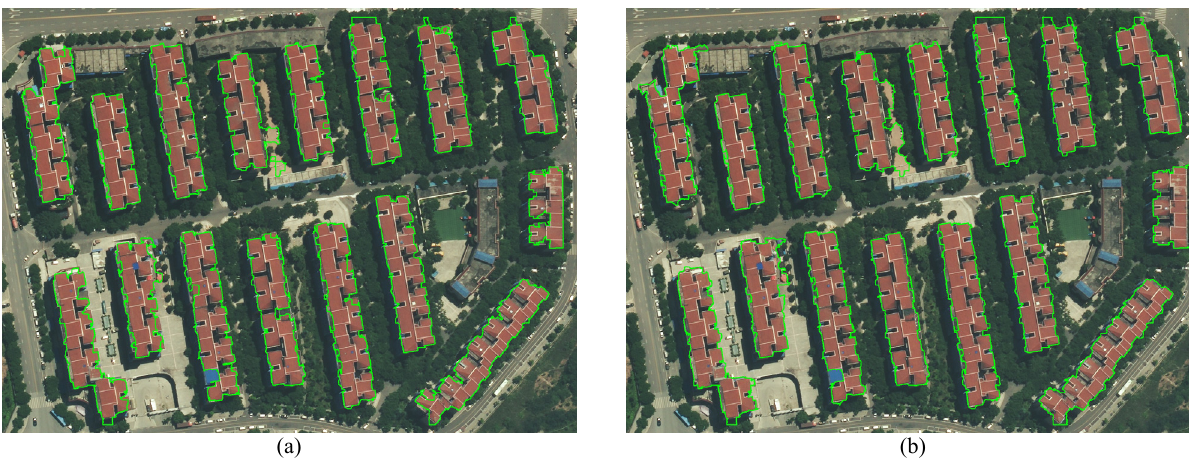
Figure 3: For image 5, (a) Result of building contours extraction using ORB+BBOF; (b) Result of building contours extraction using